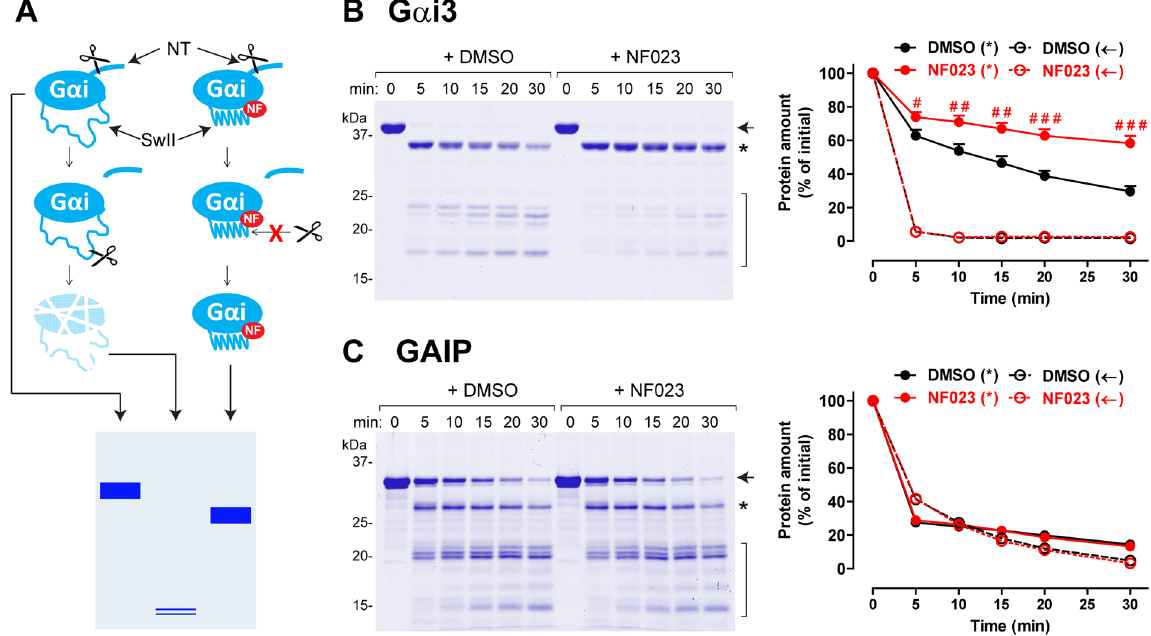
Figure 10. NF023 protects G α i3 from trypsin-mediated proteolysis. ( A ) Schematic of the principle for the limited proteolysis assays. Trypsin rapidly cleaves the N-terminus of G α i3 but digestion of the remainder of the protein depends on the conformation/protease accessibility of the SwII region. When the SwII is disordered ( left ), G α i3 is readily digested into small fragments. When the SwII adopts an ordered conformation ( right ), it becomes protected from the action of trypsin. NF = NF023. ( B ) NF023 delays G α i3 digestion by trypsin. His-G α i3 was incubated with trypsin at 4 °C in the presence or absence of NF023 (25 µ M) for the indicated times. The resulting products were separated by SDS-PAGE and stained with Coomassie Blue. Left , one gel representative of four experiments. Arrow = full-length G α i3; asterisk = N-terminally cleaved G α i3; bracket = low molecular weight proteolytic fragments of G α i3. Right , quantification of limited proteolysis data shown on the right presented as mean ± S.E. of 4 independent experiments ( # P < 0.05, ## P < 0.01, ### P < 0.001 compared to DMSO). Black = DMSO, Red = NF023. Solid lines correspond to the N-terminally cleaved G α i3 (asterisk in the gel shown on the left) and dashed lines to full-length G α i3 (arrows in the gel shown on the left). (C) NF023 does not affect GAIP digestion by trypsin. His-GAIP was incubated with trypsin at 4 °C in the presence or absence of NF023 (25 µ M) for the indicated times. The resulting products were separated by SDS-PAGE and stained with Coomassie Blue. Left , one gel representative of three experiments. Arrow = full- length GAIP, asterisk = larger proteolytic fragment of GAIP, Bracket = smaller proteolytic fragments of GAIP. Right , quantification of limited proteolysis data shown on the right presented as mean ± S.E. of 3 independent experiments. Black = DMSO, Red = NF023. Imagens of the full gels presented in this figure are shown in Supplementary